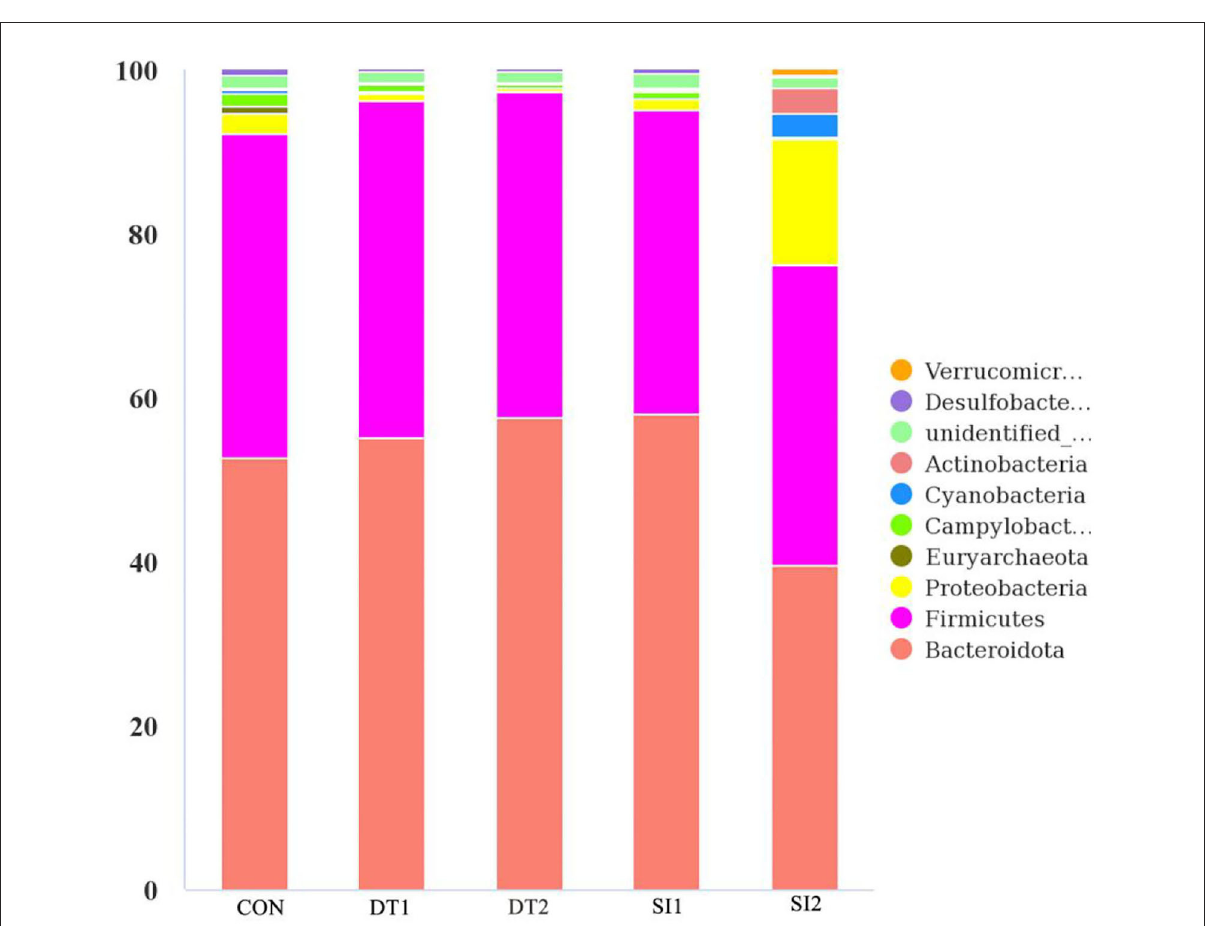
FIGURE4 The top 10 most abundant taxa of cecal microbiota at the phylum